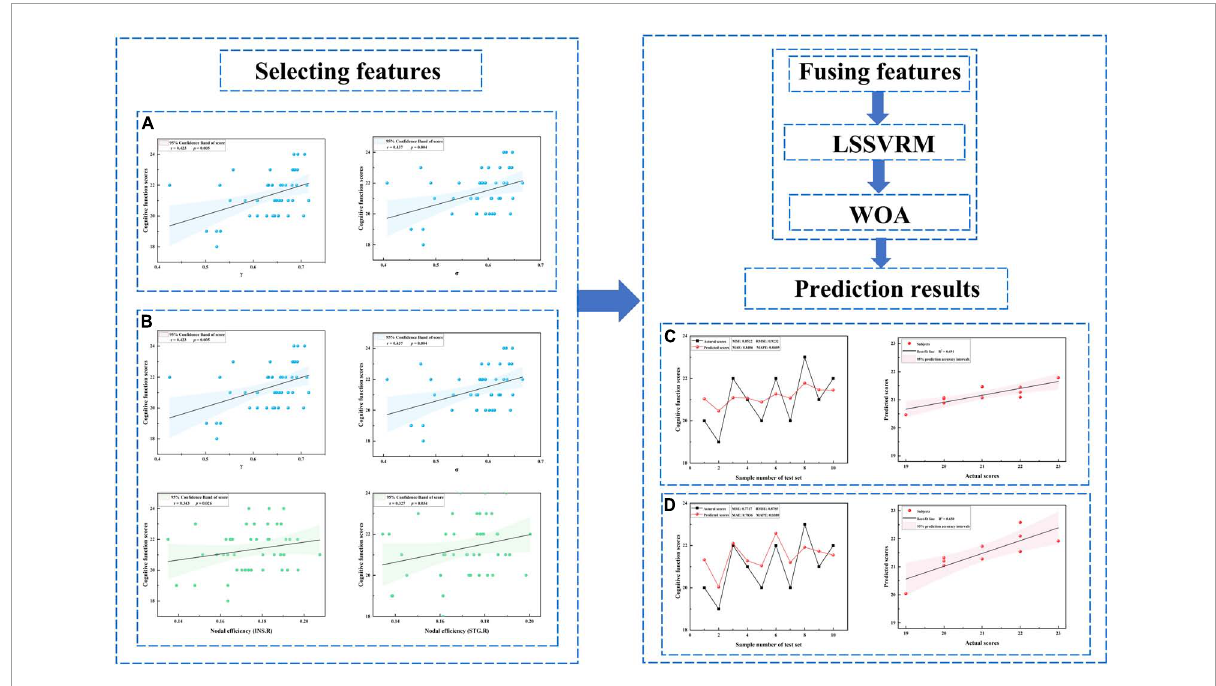
FIGURE4 Prediction results. (A) Selected features including only global measures. (B) Selected features including both global and nodal measures. (C) Prediction results for panel (A) . (D) Prediction results for panel (B) . LSSVRM, least squares support vector regression machine; WOA, whale optimization